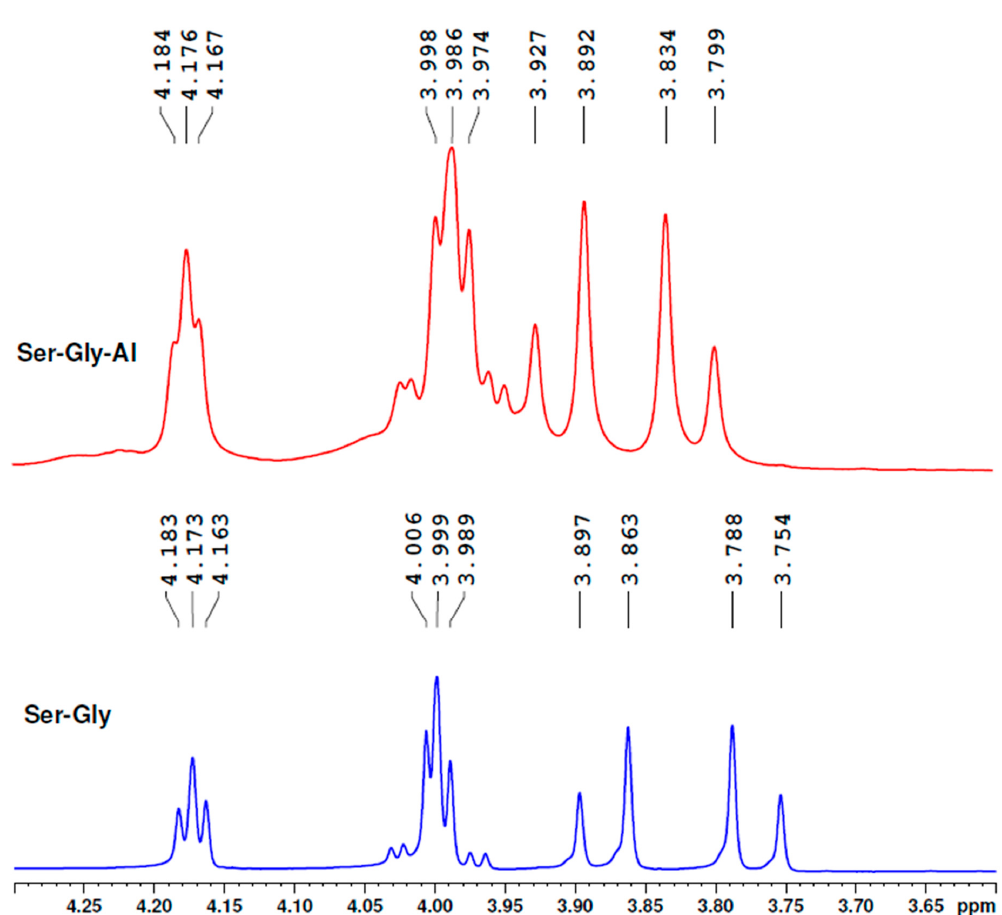
Figure 13. 1 H-NMR spectra of seryl-glycine peptide in the presence of aluminium sulphate demonstrate that Al ions bound to the hydroxyl group of serine.